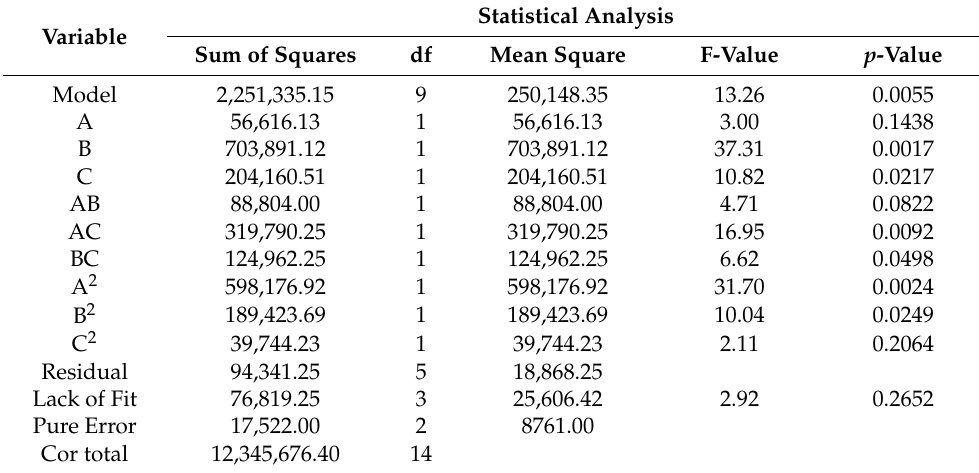
Table 6. Variance analysis of the model.